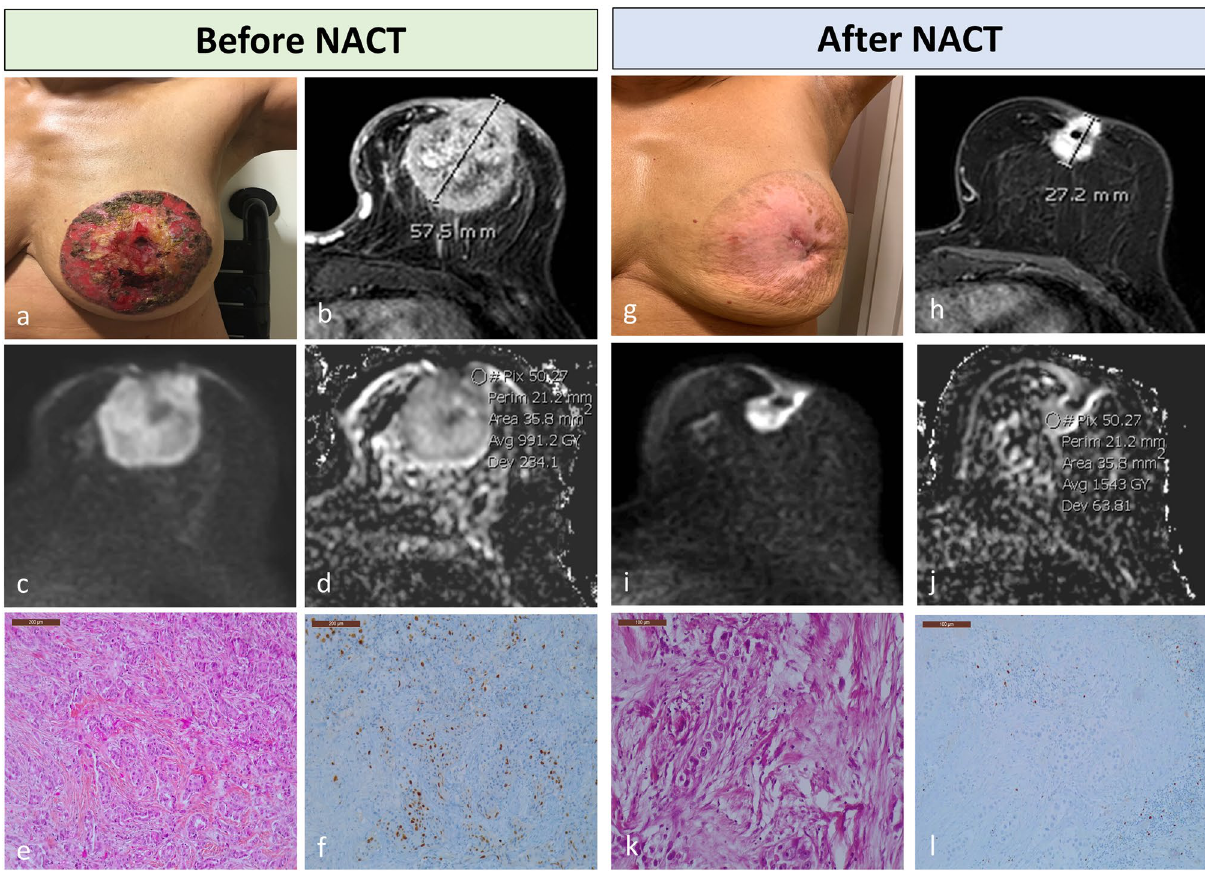
Figure 2. Images of a 61-year-old woman who received neoadjuvant chemotherapy (NACT) for grade 3 hormone receptor–negative/human epidermal growth factor receptor–positive cancer of the left breast. The patient had residual disease at surgery and therefore did not experience pCR (RCB class: II). Before NACT: physical examination findings showing a large skin ulceration (cT4bN1) ( a ), axial DCE T1-WI showing a large, irregular, and heterogeneous mass of size 5.75 cm in LD ( b ), axial DWI showing a high signal intensity mass at b = 800 ( c ) and an ROI-ADC value of 0.991 × 10 –3 mm 2 /s placed on the darkest part of the ADC map ( d ), HE staining of core needle biopsy showing an IDC SBR3 ( e ). IHC of the core needle biopsy showing nuclear positivity for a Ki-67 proliferation index of 30% ( f ). After NACT: cicatrization of the skin ulceration (ycT2N0) ( g ), axial DCE T1-WI showing a residual mass of size 2.72 cm in LD corresponding to a partial response (decrease of 52.7% in LD) ( h ), axial DWI showing a residual high-signal-intensity mass at b = 800 ( i ), and an ROI-ADC value of 1.543 × 10 –3 mm 2 /s placed on the darkest part of the ADC map avoiding clip artifacts (increase of 55.7% in ROI-ADC) ( j ), HE staining of the surgical specimen showing a residual IDC SBR2 of size 2.2 cm (ypT2N1 (mi) , RCB-II) ( k ), and IHC showing nuclear positivity for a residual Ki-67 proliferation index of 5% ( l ). ROI region of interest, ADC apparent diffusion coefficient, pCR pathologic response, RCB residual cancer burden, DCE dynamic contrast enhanced, WI weighted imaging, LD largest diameter, DWI diffusion-weighted imaging, HE hematoxylin and eosin, IDC invasive ductal carcinoma, IHC of pre- and post-NACT ADC values can be used to estimate the change in Ki-67 index in a retrospective study that included 87 patients with invasive breast cancer and showed a negative correlation between the change in ADC values and the Ki-67 index due to NACT 24 . The authors suggested that changes in ADC values might be used as a surrogate marker for changes in the Ki-67 index in the NACT response of patients with invasive breast cancer. Because the authors did not consider the radiologic response or the patients who achieved pCR, the comparison with our study was limited. This study had some limitations. First, only one radiologist performed ROI-ADC measurements. Second, only one pathologist assessed the Ki-67 proliferation index. However, the pathologist followed the recommendations of the international Ki-67 in breast cancer working published to minimize the variation in analytical practice and to standardize the methodology 3 . Our study has several strengths. All patients underwent two consecutive MRI examinations before and after the same NACT protocol. All MRI examinations were standardized and performed prospectively using the same 3-T magnet. The post-processing was standardized. This study demonstrated that ADC measurement is a powerful functional parameter that offers information on tumor cellularity and could provide reliable, fast, noninvasive, and inexpensive prediction of breast cancer response to NACT. DWI does not require contrast agent injection and lasts for only a few minutes. After NACT, a significant increase in breast